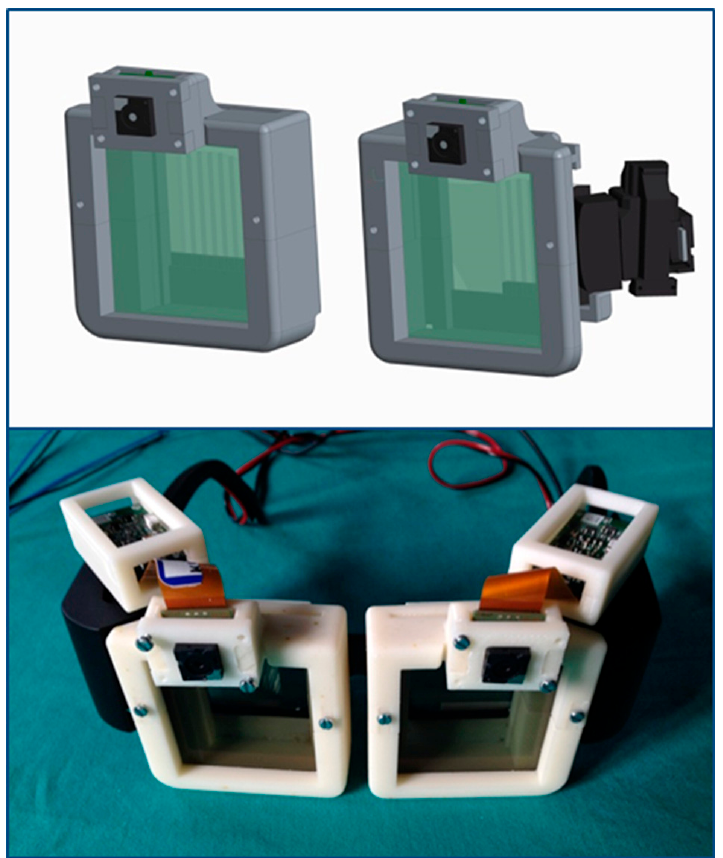
Figure 1. On the top: CAD schematic of the hybrid video/optical see-through head-mounted display comprising the supports for the electro-optical shutters and a pair of stereo cameras mounted on top of the two waveguides of an OST HMD. On the bottom: the HMD.